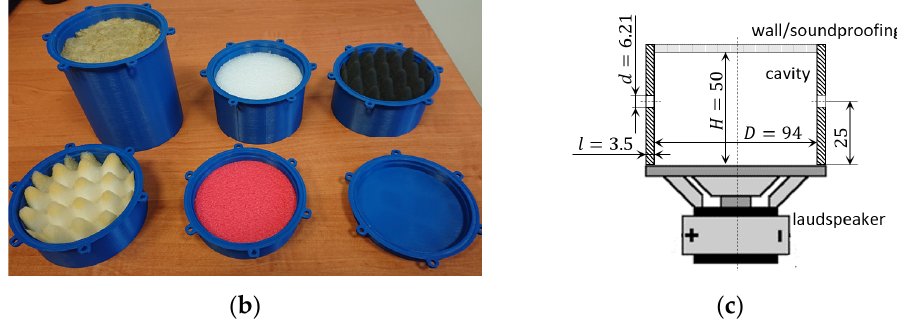
Figure 1. The synthetic jet actuator: ( a ) the compound actuator for Case 0; ( b ) the top part of the actuator body with the soundproofing filling; ( c ) the schema of the actuator.